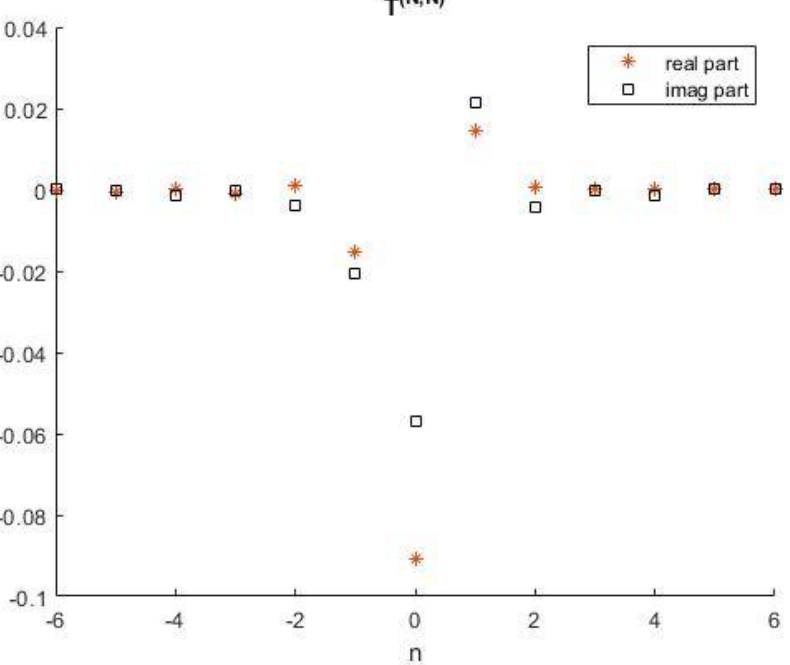
= 140° , and (cid:1840) (cid:3046)